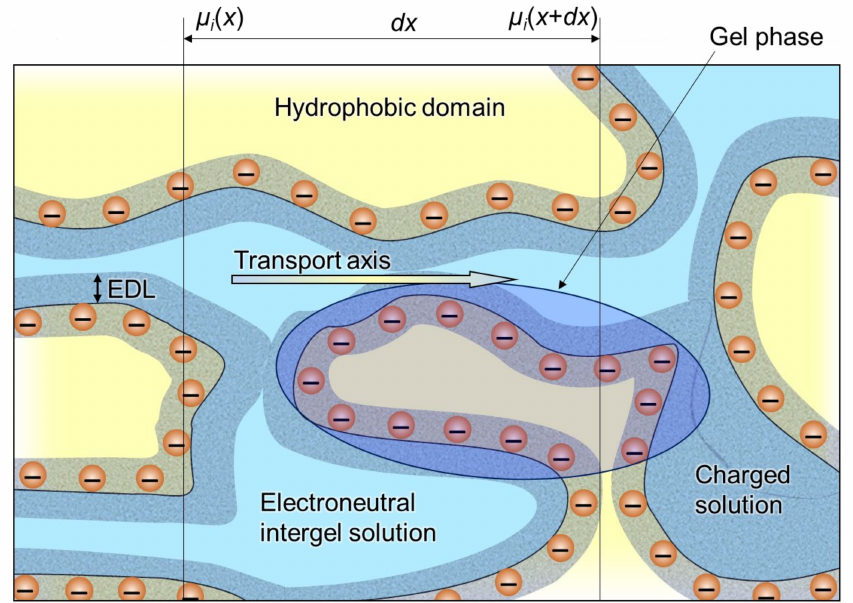
Figure 7. Schematic representation of the IEM structure with its main elements: fixed ions (shown as circles with “ − ”), EDL formed at the internal interfaces, and electroneutral solution in the center zone of intergel spaces. The gel phase includes the polymer matrix bearing the fixed ions and the EDL. Redrawn from